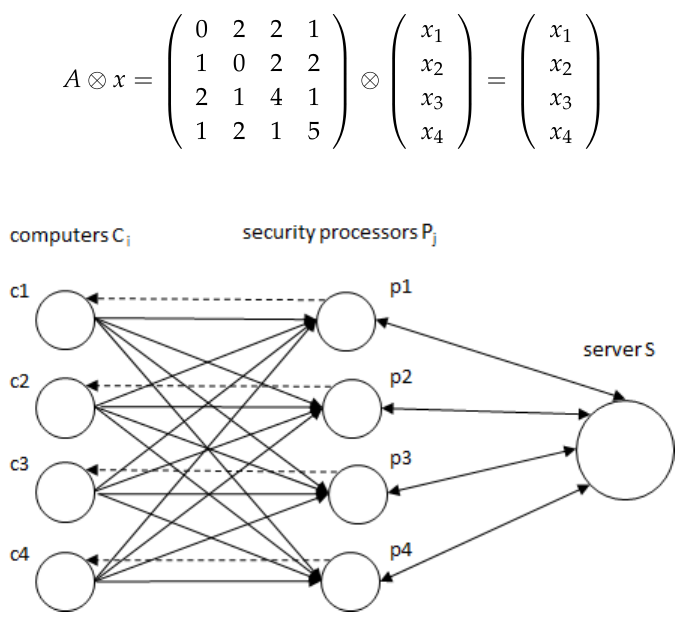
Figure 1. Data transfer system